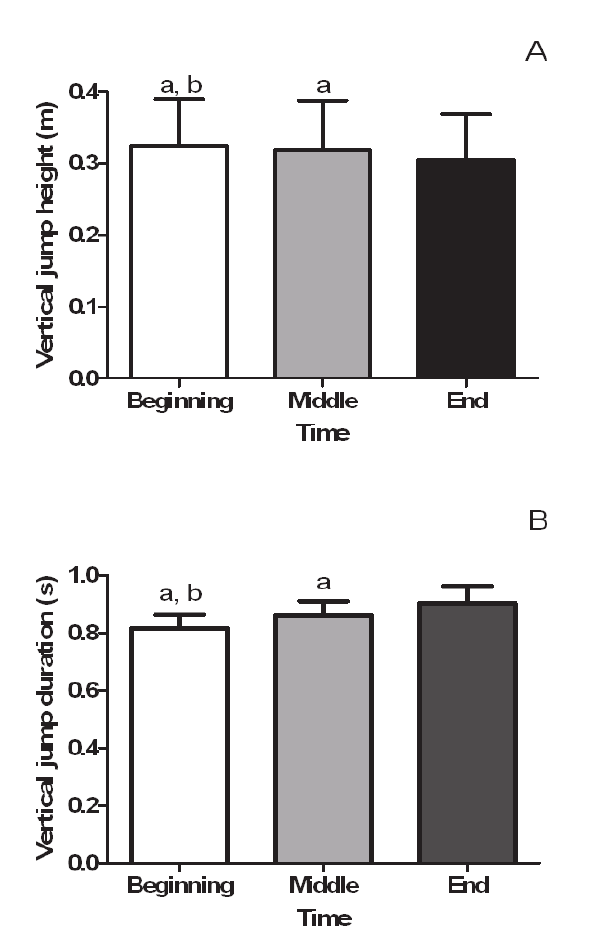
Figure 3. (A) Percentage of variance explained by the first principal component (PC1) for all instants (A). (B) It shows the contribution (loading) of each segment to the first PC. a different from thigh ( p < .01); b different from trunk ( p <